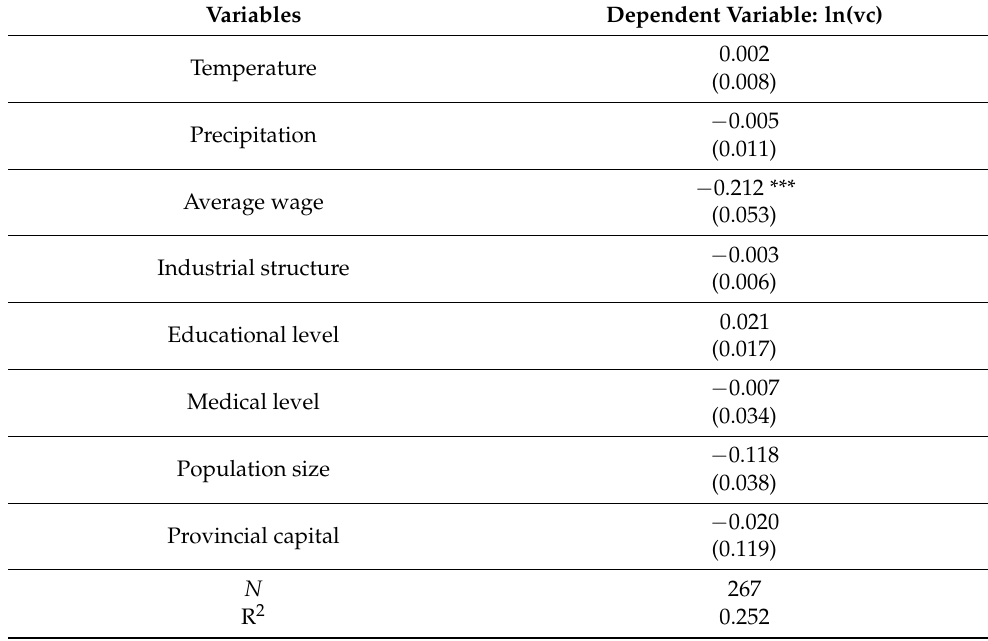
Table A1. Determinants of